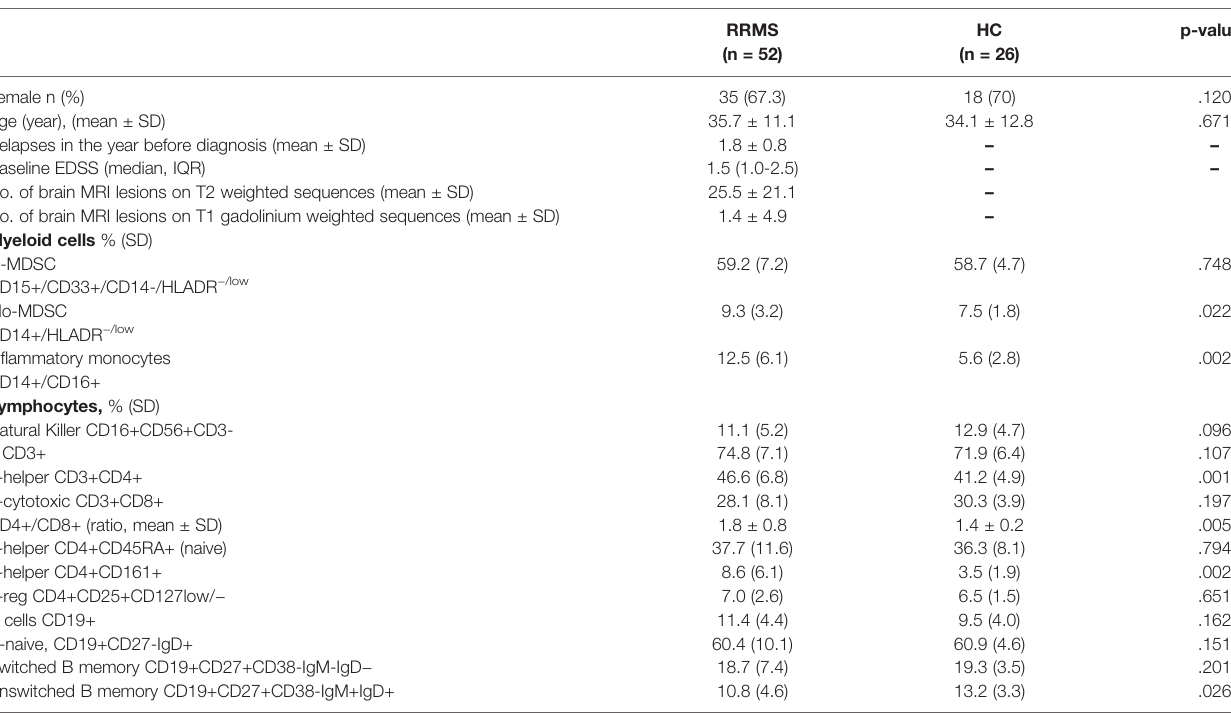
TABLE 1 | Baseline cohort characteristics and cell